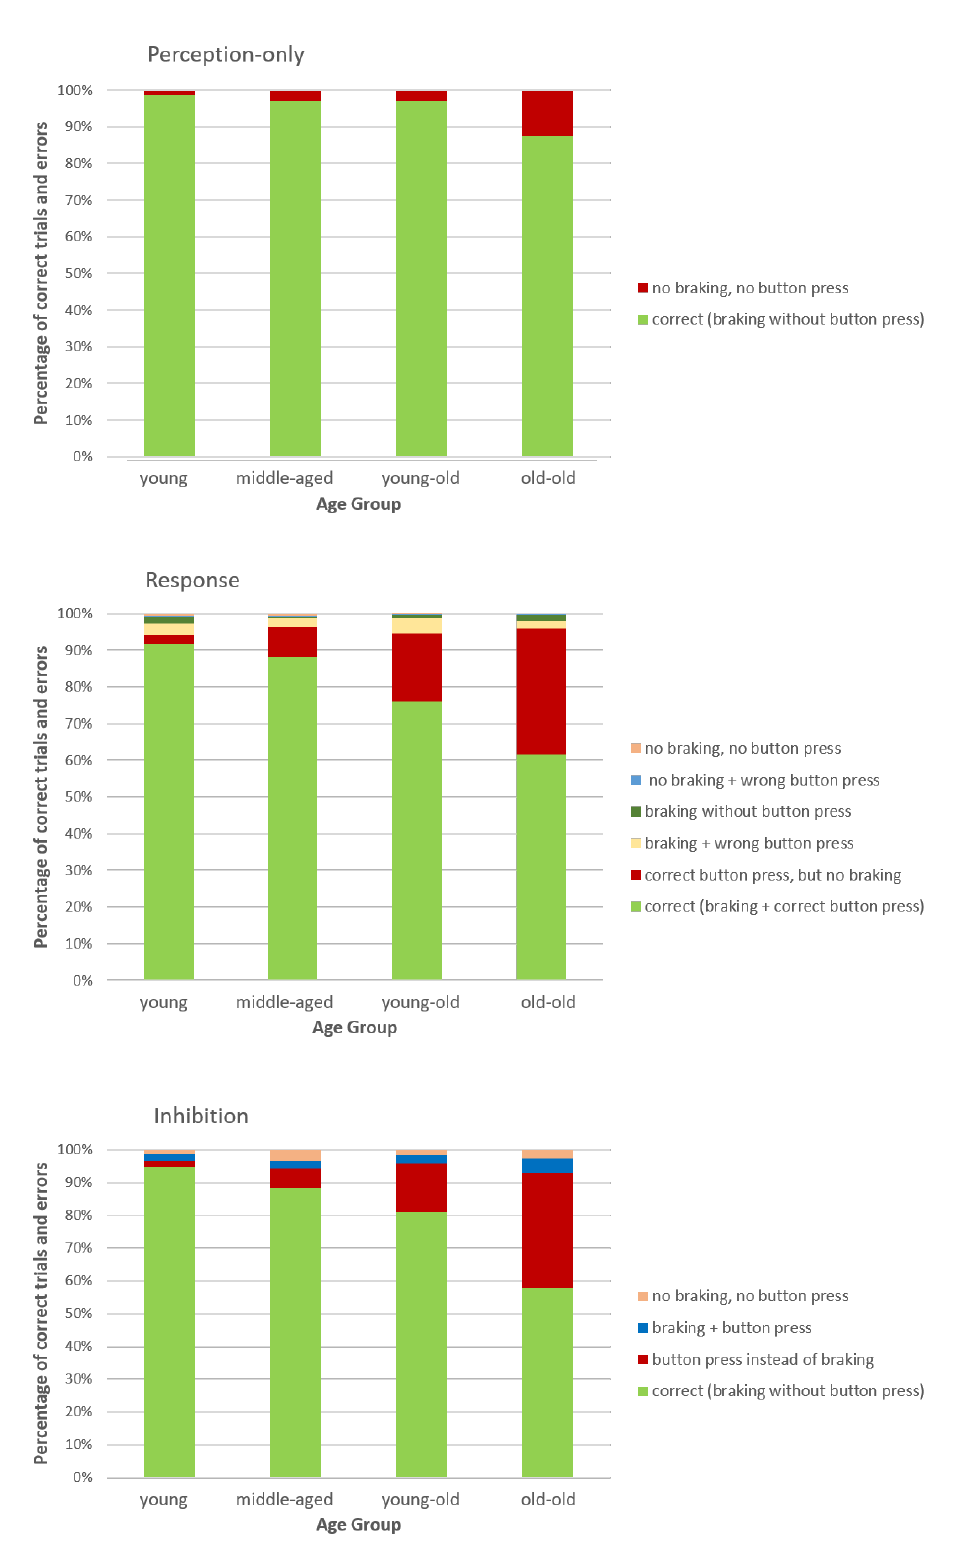
Figure 5. Proportion of correct braking reactions and various types of errors in percent, presented separately for perception-only, response and inhibition task and the four age groups. Please note especially the age-related increase in the proportion of errors, in which the correct response to the distraction stimulus was given, but the brake response was omitted (red bars in response and inhi- bition).